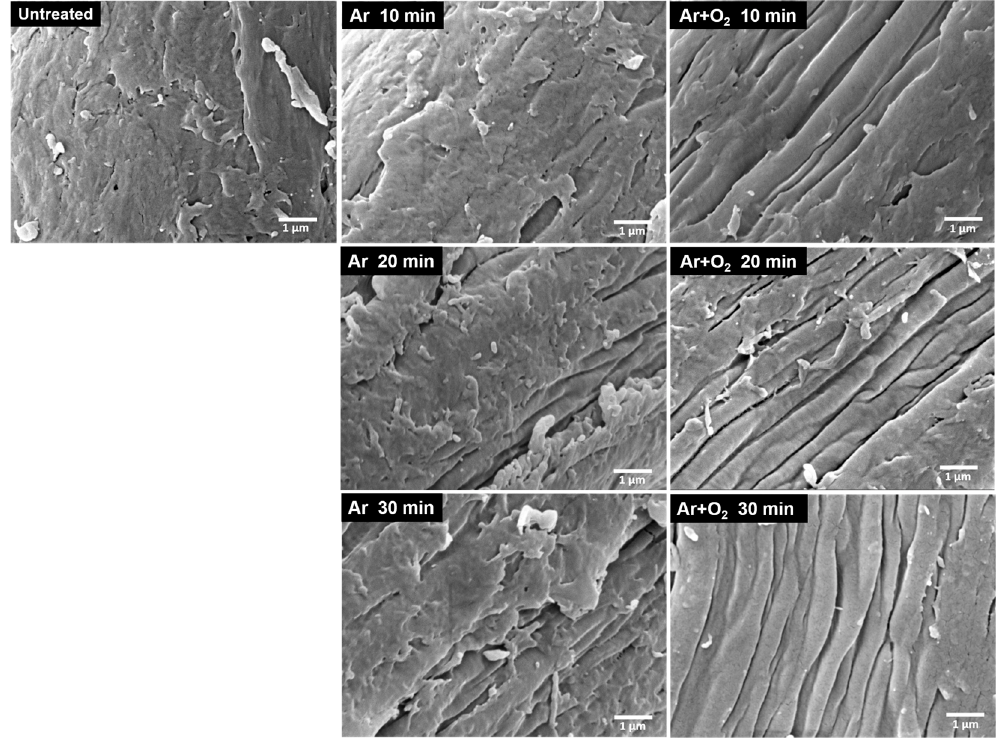
Figure 9. SEM images of the morphology of BFs treated with different gas plasmas for various treatment times at 15,000 × .